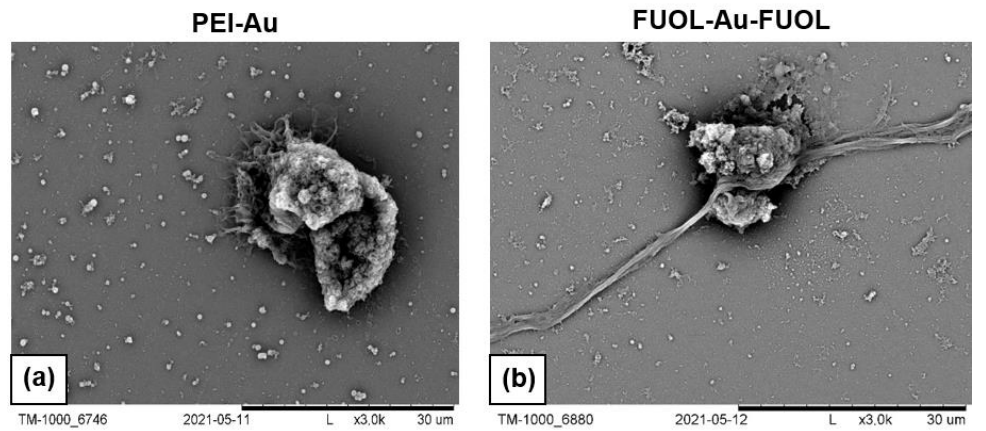
Figure 8. SEM visualization of HDF cells immobilized within designed scaffolds after 10-day culture. Key to the symbols : ( a ) PEI-Au : polyethylenimine with AuNPs incorporating; ( b ) PEI-Au-FUOL: polyethylenimine with AgNPs and FUOL incorporating. Magnification: 3000×.